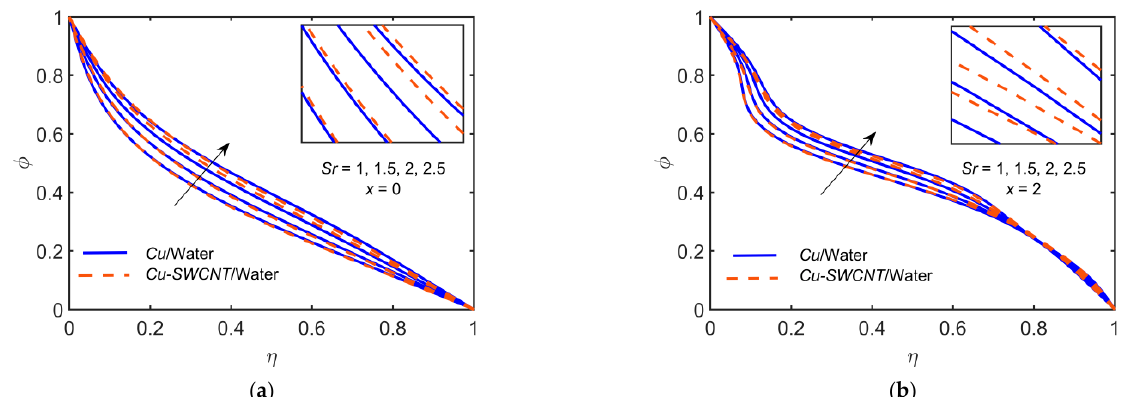
Figure 13. The 𝜑 profile at ( a ) 𝑥 = 0 and ( b ) 𝑥 = 2 for distinct values of 𝑆𝑟 . Figure 13. The ϕ profile at ( a ) x = 0 and ( b ) x = 2 for distinct values of Sr